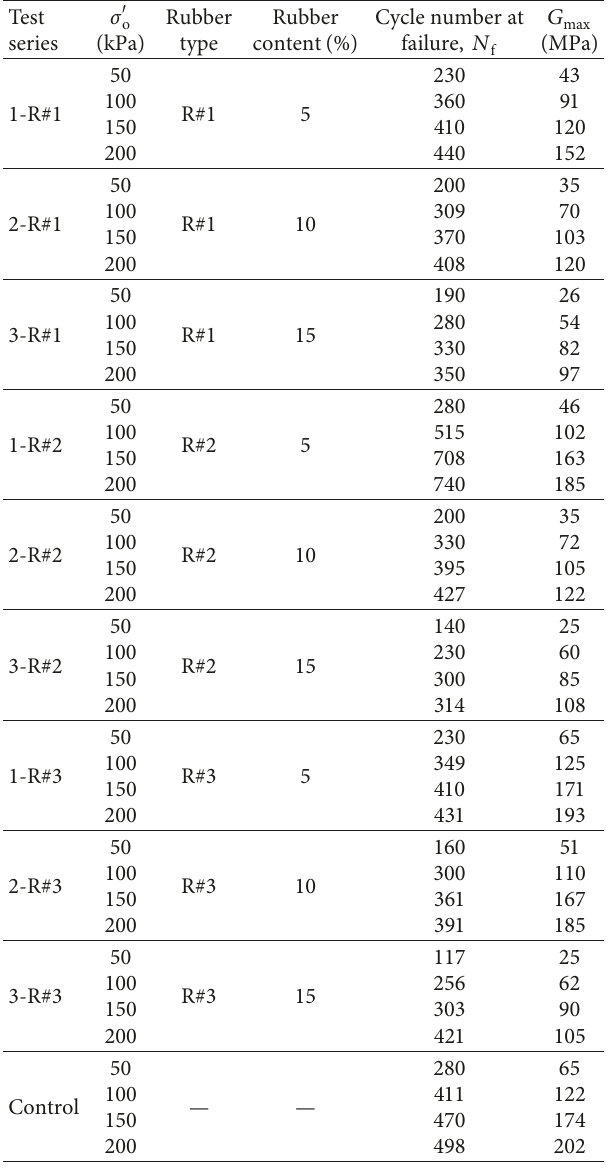
Figure 2: The grain size distribution curves of the rubber and sand. Table 1: Summary of parameters of dynamic